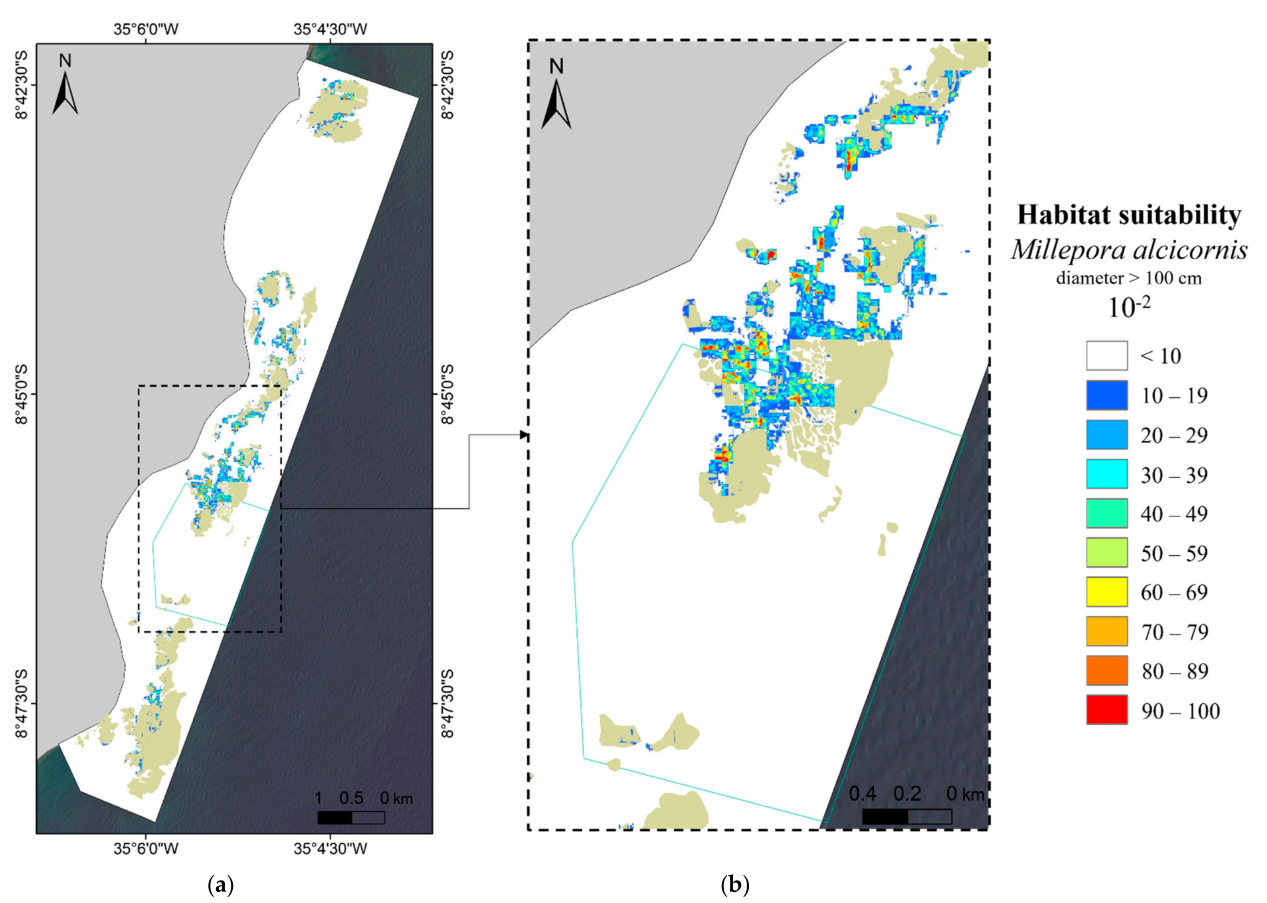
Figure 9. MaxEnt georeferenced output showing relative habitat suitability for large colonies of Millepora alcicornis . ( a ) Complete map of habitat suitability in Tamandar é , PE; ( b ) map focusing on the no-take zone and surrounding reefs. The reefs are pictured in light brown to enable the visualization of the